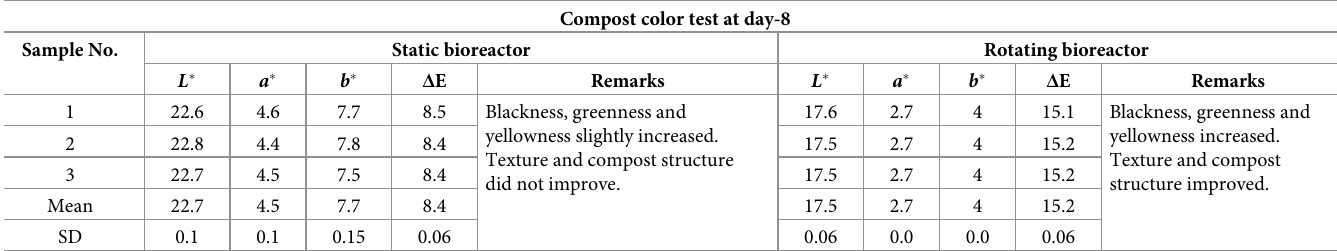
Compost color test at day-8